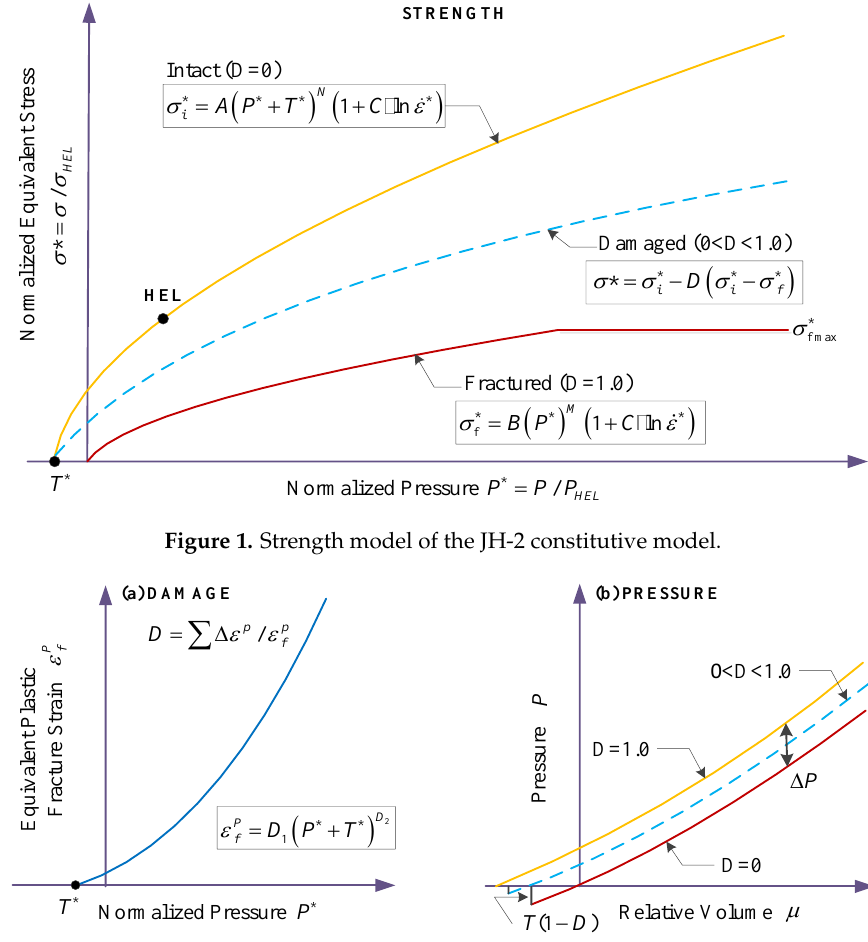
Figure 2. Damage model ( a ) and EOS model ( b ) of the JH-2 constitutive